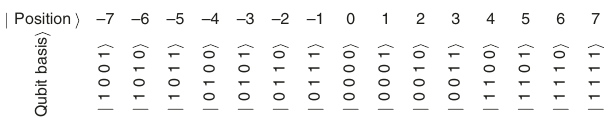
Fig. 2 Mapping of multi-qubit states to position states. Multi-qubit states are re-ordered in such a way that the state 0 j ið 1 j iÞ of the last qubit corresponds to even (odd) position numbers and its correspondence in the